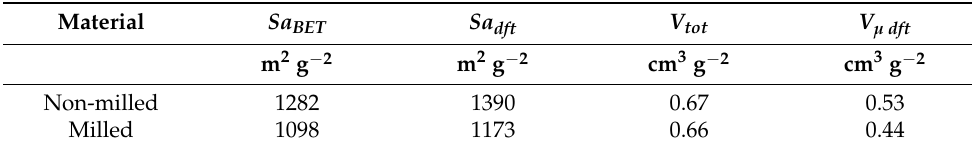
Table 1. Porosity characteristics of